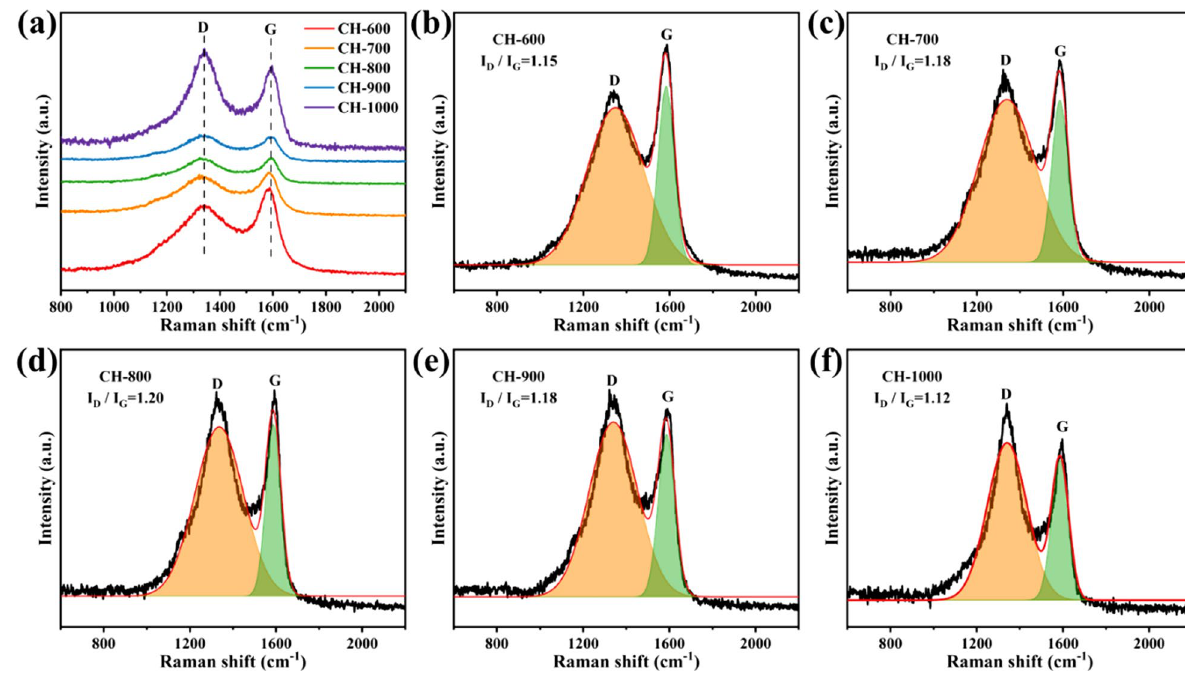
Fig. 5 Raman spectra of CH: a general figure, b CH-600, c CH-700, d CH-800, e CH-900, and f